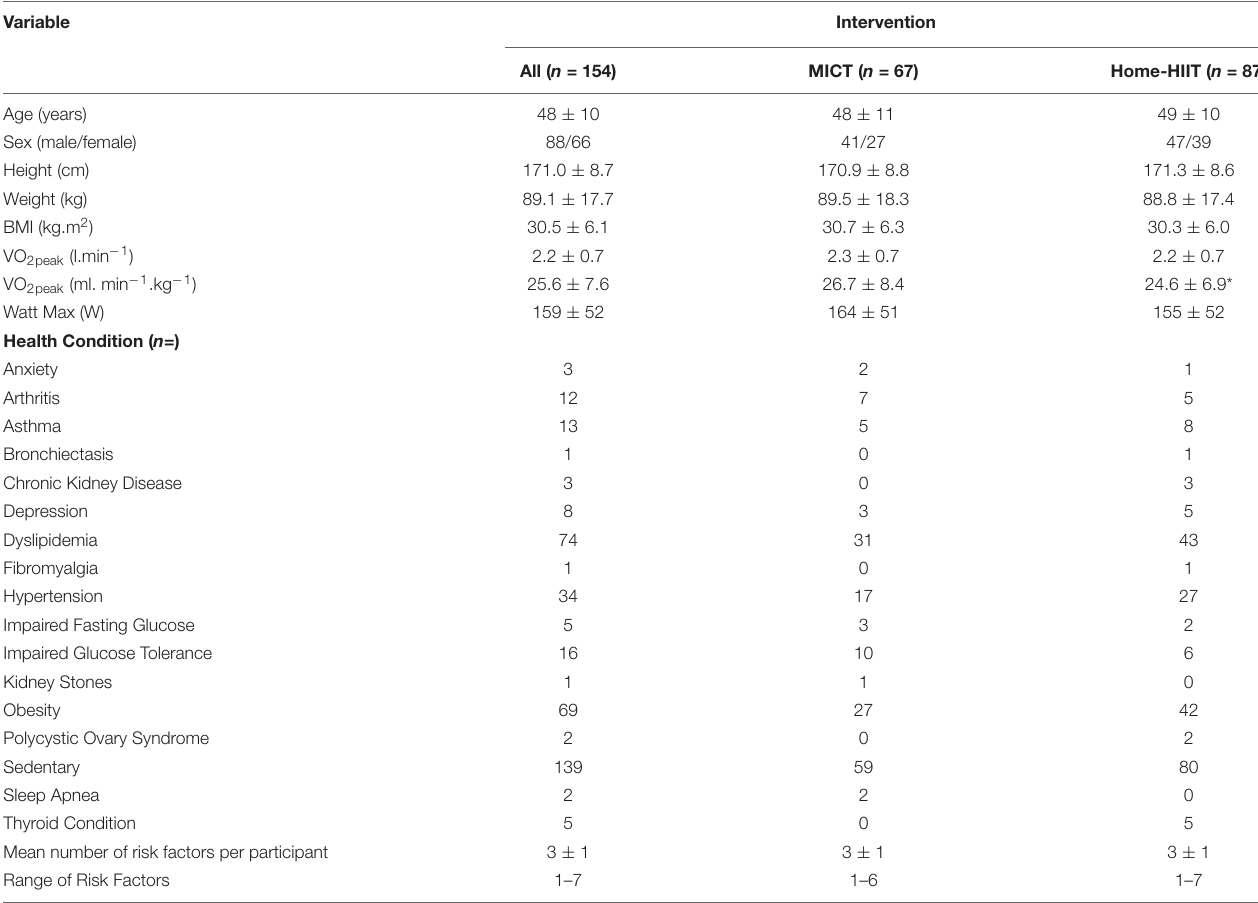
TABLE 3 | Participant